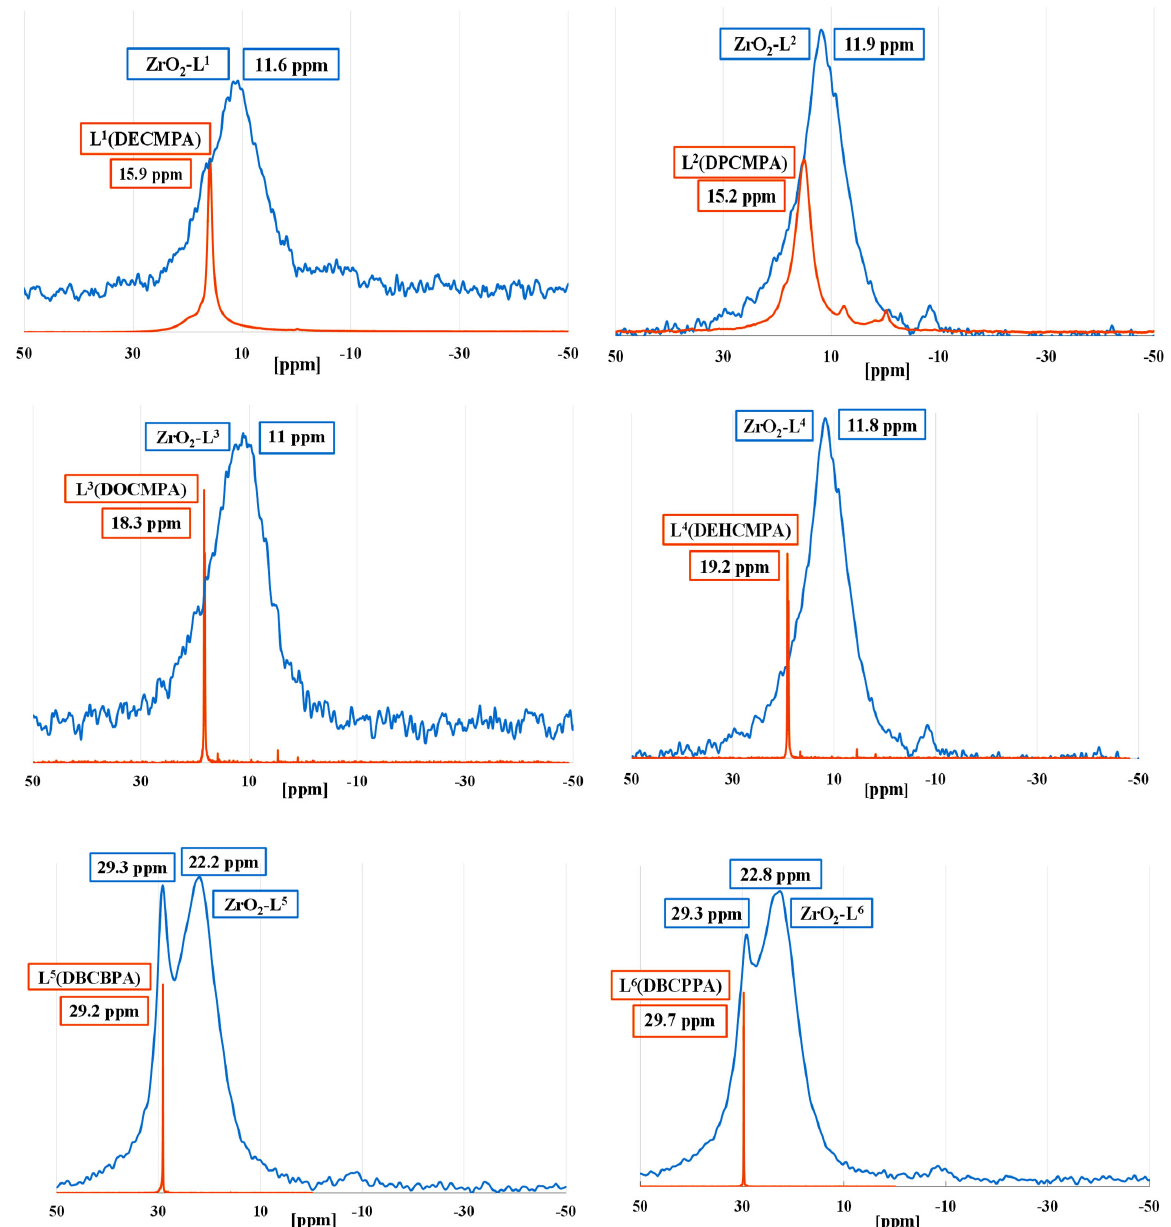
Figure 2. Solid-state 31 P NMR spectra of ZrO 2 -L n nanomaterials (blue) and liquid-state 31 P NMR Figure 2. Solid ‐ state 31 P NMR spectra of ZrO 2 ‐ L n nanomaterials (blue) and liquid ‐ state 31 P NMR spectra of ligands (red). spectra of ligands (red).